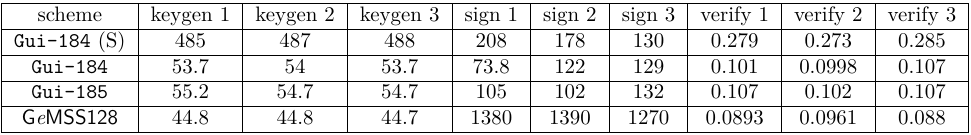
Table 21: Median in mega cycles (Mc) for each cryptographic operation, for a Skylake process (LaptopS). We compare the Gui implementation from SUPERCOP (S) with MQsoft . For three different keypairs, documents of length 59 bytes are signed then verified. The EUF-CMA property is implemented for all schemes.